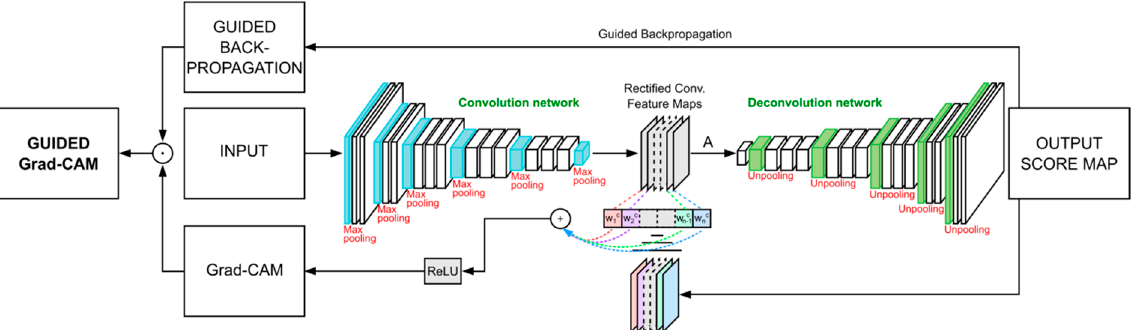
Figure 4. Guided Grad ‐ CAM for semantic segmentation.